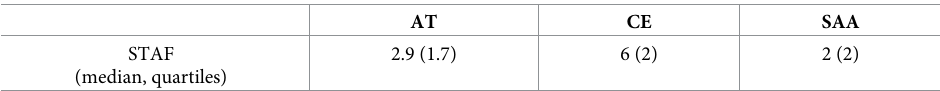
Table 3. STAF score for each